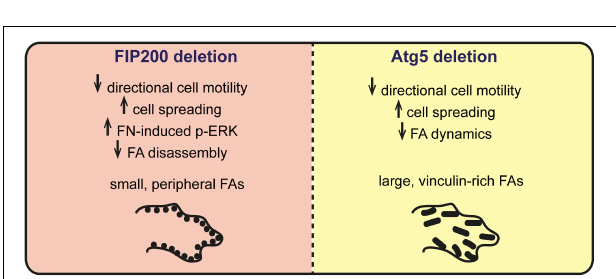
FIGURE 8 | Summary of phenotypes associated with FIP200 or Atg5 loss of function. Loss of FIP200 in MCF10A cells results in small, peripheral focal adhesions (FAs), decreased directional cell motility, increased fibronectin-induced cell spreading, increased fibronectin-induced phospho-ERK (p-ERK) and a defect in FA disassembly. Loss of Atg5 in MCF10A cells results in decreased directional cell motility, increased fibronectin-induced cell spreading, and large, vinculin-rich FAs showing decreased